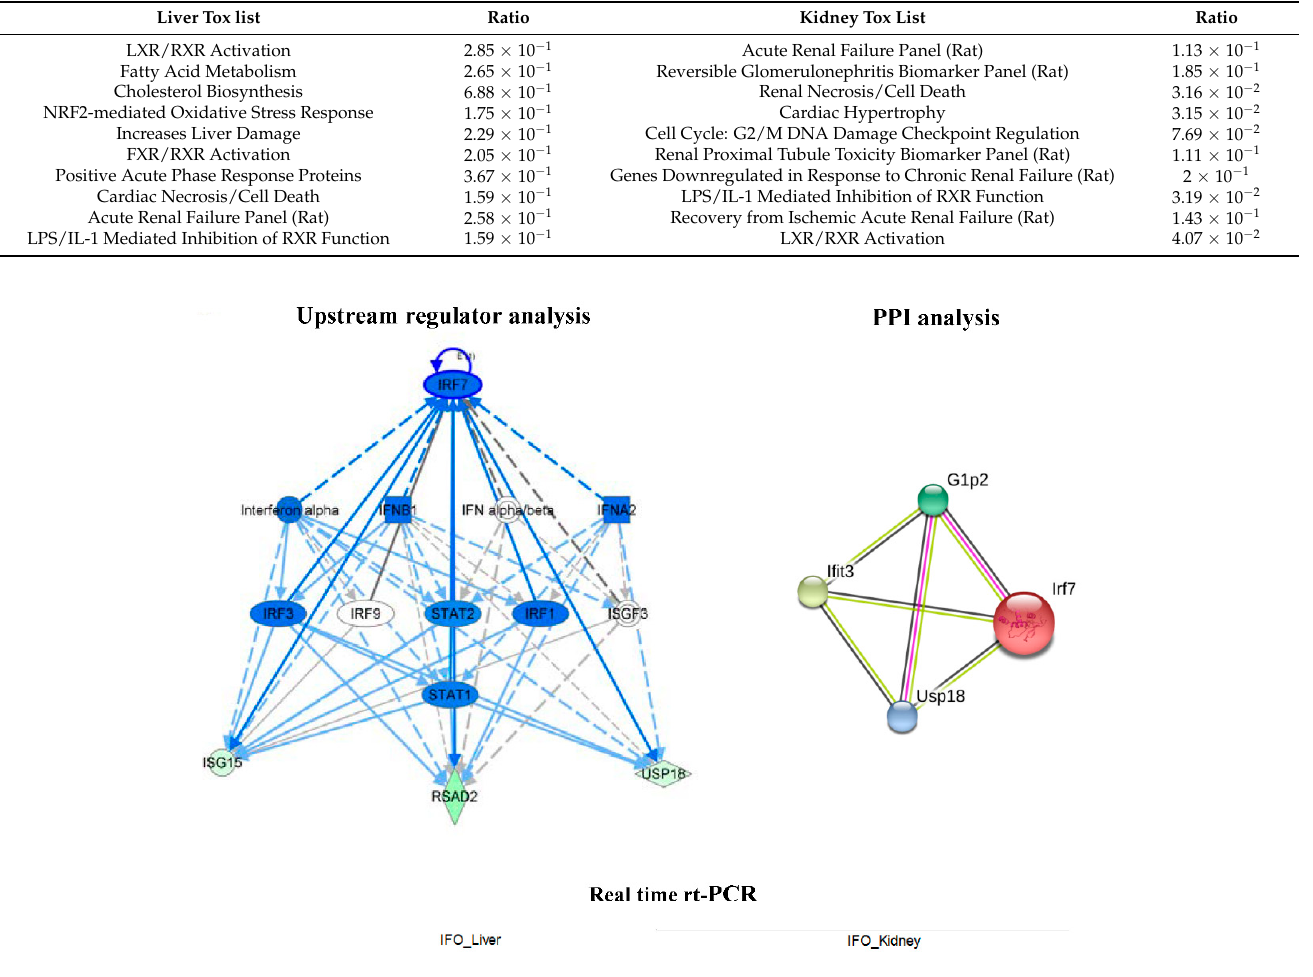
Table 6. Differentially Expressed Genes (DEGs) 1 week after treating rats with ifosfamide at 100 mg/kg bw/day.